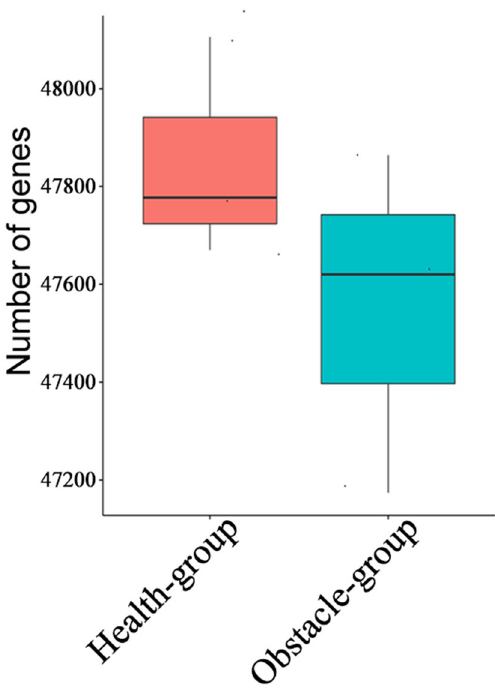
Figure 2. Differences in microbial gene number and kingdom abundance between the two groups. Boxplots indicate the minimum, maximum, median and upper and lower quartiles of the number of genes in each group. In a boxplot, the black line indicates the